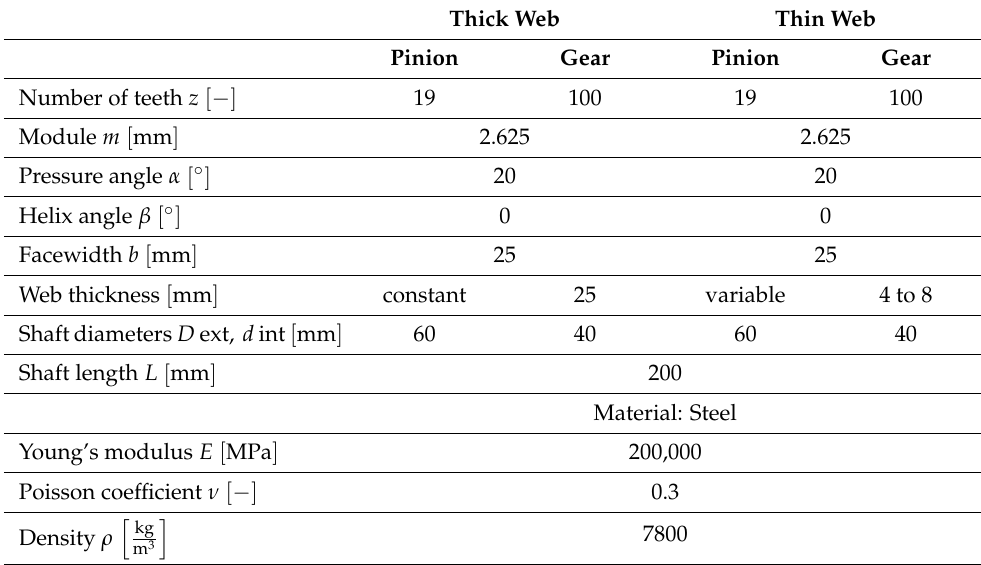
Table 1. Test transmission main parameters.